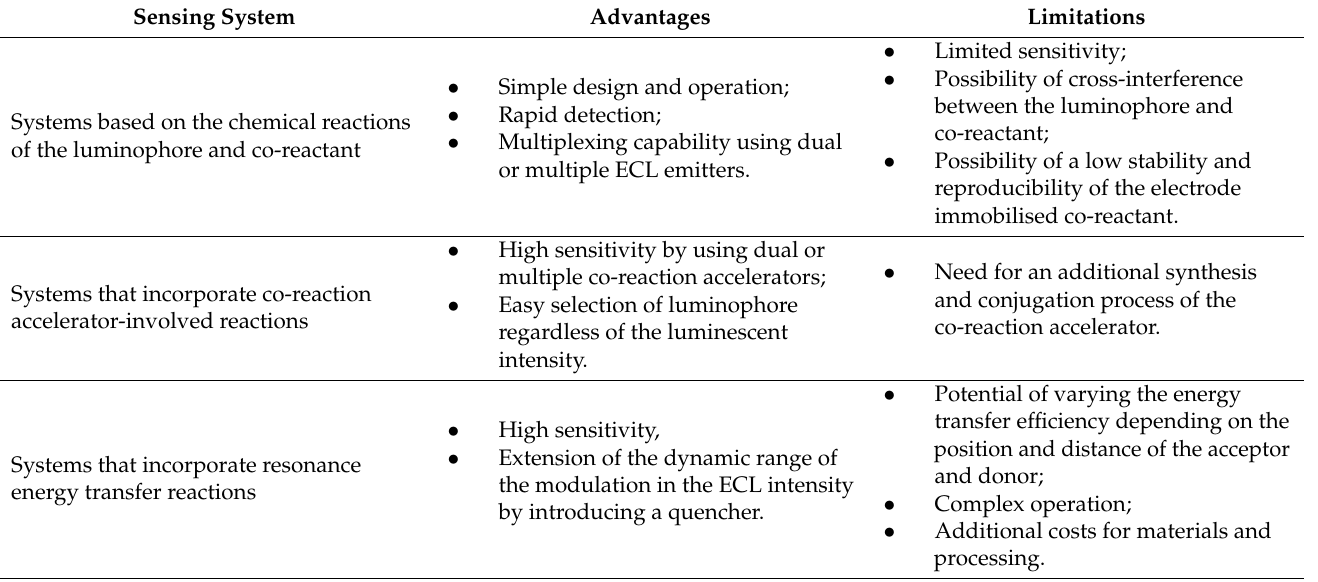
Table 2. Advantages and disadvantages of the biomarker detection ECL